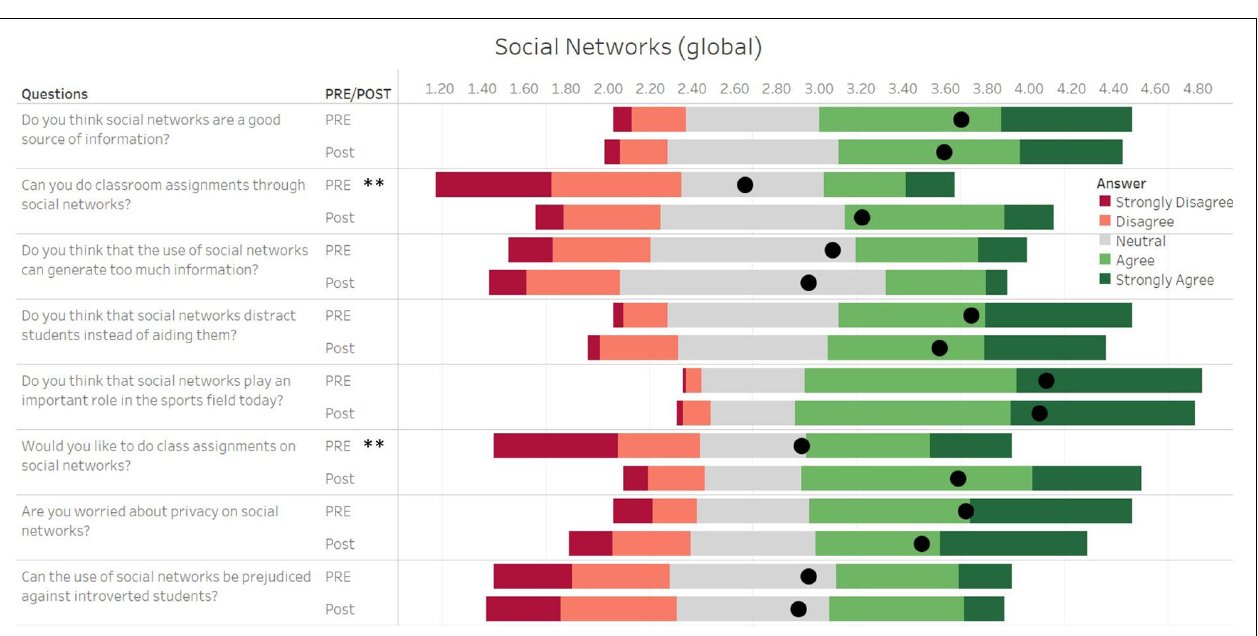
FIGURE 4 | Student responses for questions in the survey related to social networks. The length of each bar of the Gantt chart represents the number of corresponding responses before (PRE) and after (Post) activity, with the black dot representing the average of all values. The responses were recorded on a five-point Likert-type scale, where 1 represented a strong disagreement with the question and 5 represented a complete agreement to the question. ** Represents a significant difference between pre- and post-values at p < 0.001.